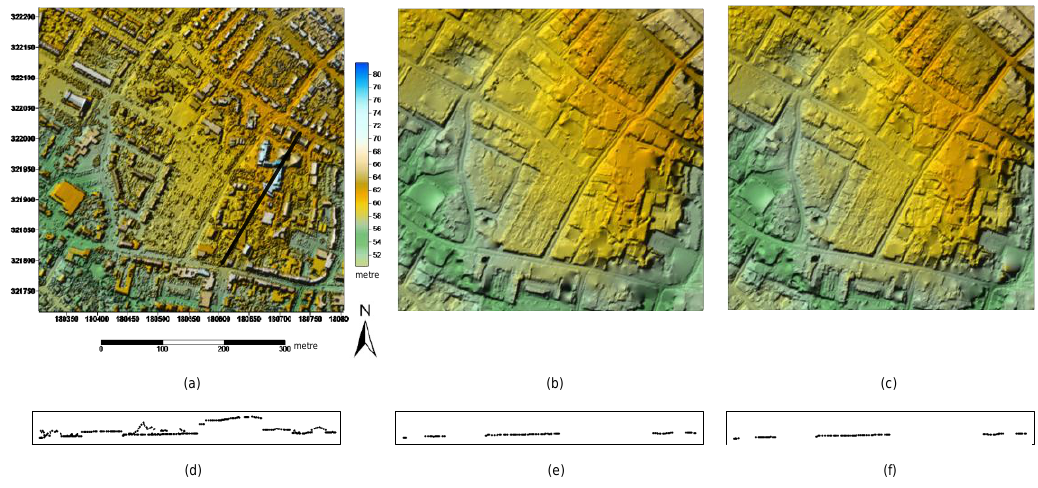
Figure 15. Results of the proposed method filtering AHN Test Site 2: ( a ) DSM generated from raw point clouds (the dark line denotes profile position); ( b ) DEM generated from true ground points; ( c ) DEM generated from ground points derived by the proposed filter; ( d ) LiDAR points along the profile in ( a ); ( e ) LiDAR points along the profile in ( b ); and ( f ) LiDAR points along the profile in ( c ).